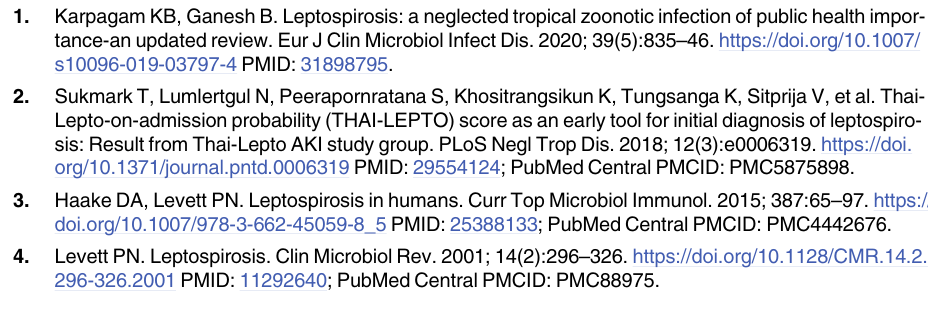
S2 Fig. ROC curves of combined miR-601 and miR-630 levels. (TIF) S3 Fig. miRNA-mRNA network; a total of 118 nodes with 185 edges. (PDF) S1 Table. The differentially expressed miRNAs between patients with anicteric and icteric